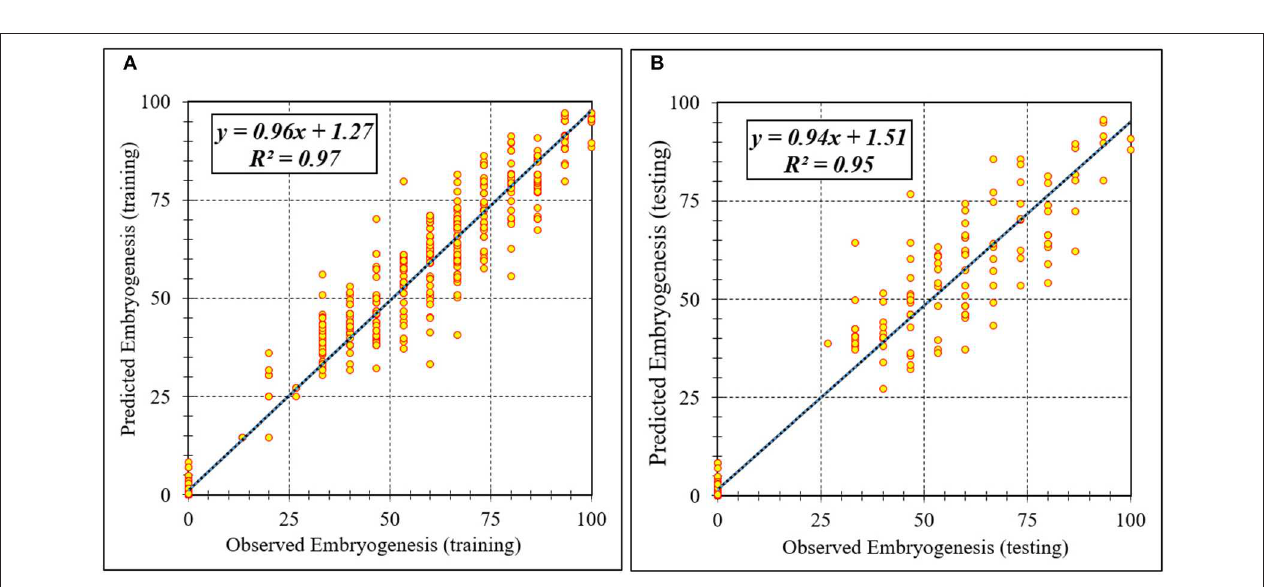
FIGURE 4 | Scatter plot of model predicted vs. observed values of embryogenesis of chrysanthemum obtained by ANFIS model. (A) Training set ( n = 810); (B) Testing set ( n = 270). Fitted simple regression line on scatter points was indicated by a solid